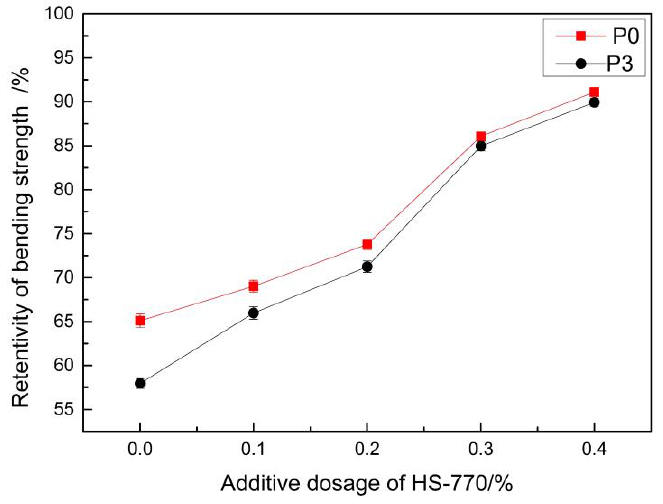
Figure 10. The effect of the light stabilizer on the strength retention ratios of the repair materials.